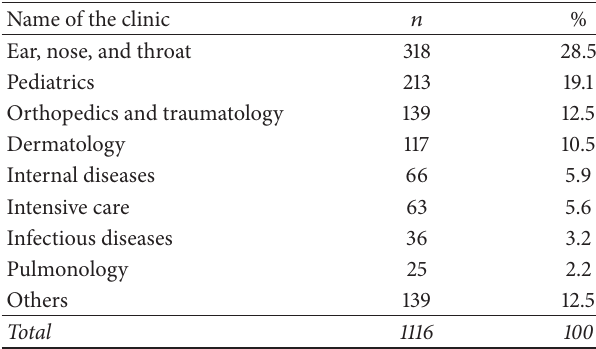
Table 1: Distributions of S. aureus strains according to the clinics.